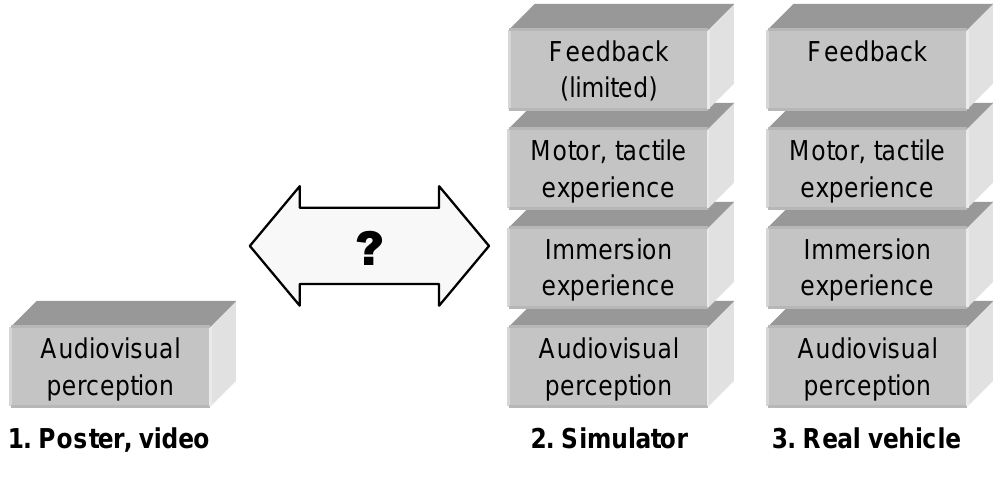
Fig. 1. Sensational features provided by the teaching aids in the accepted hierarchy. The com- Figure 53: Presentation of paper plexity and cost of implementation increase top to bottom and left to right. The question mark represents the gap.